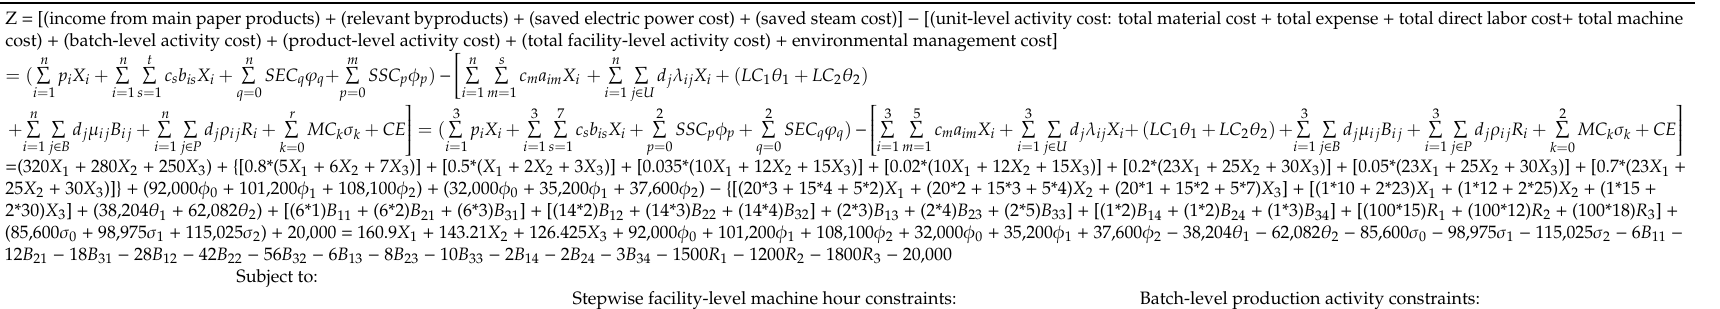
Table A1. The mathematical programming model with the example data of Table